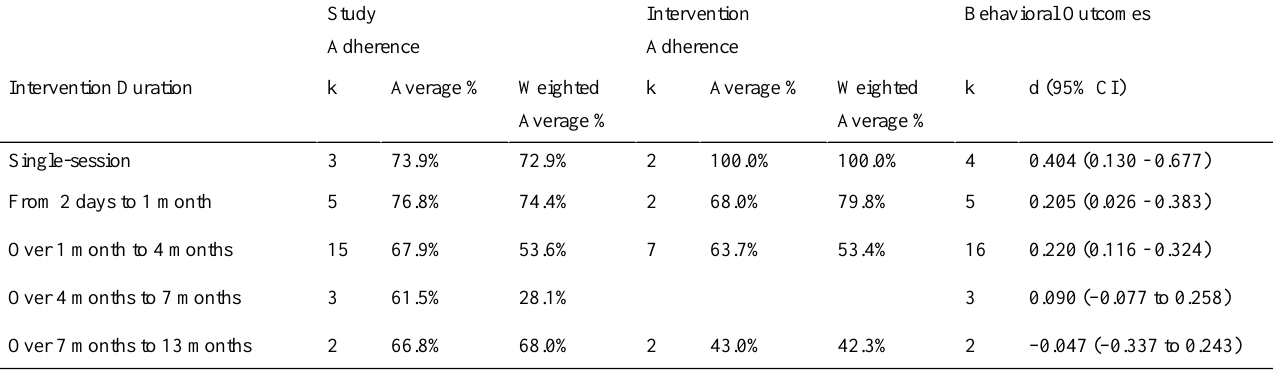
Table 9. Intervention duration, adherence, and behavioral outcomes